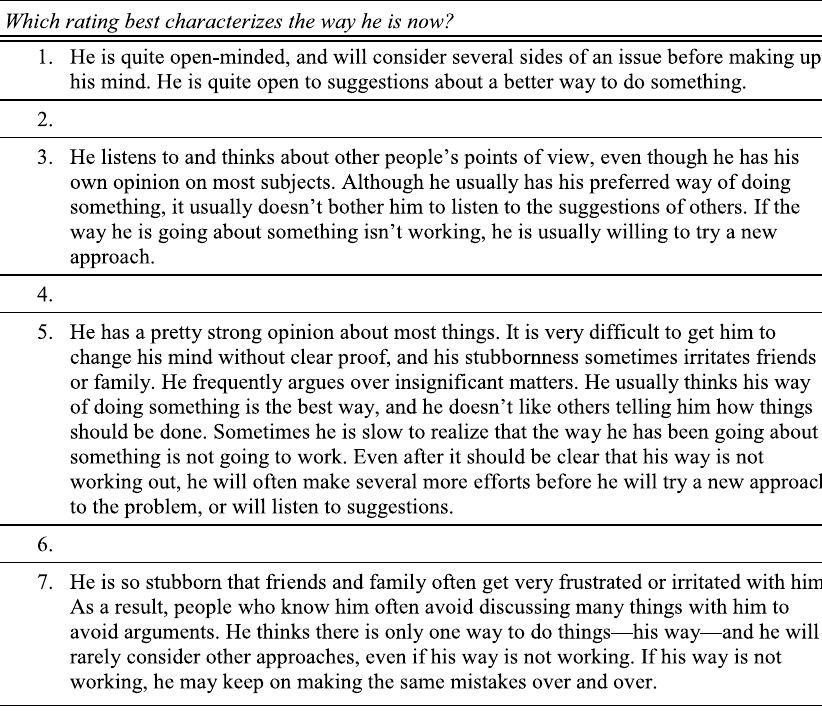
Fig. 1. Example of a rating sheet for one item of the ISPC (total number of items: 29). For each item, a rating of 1 indicates excellent, 3 average, 4–5 moderate disturbance, and 6–7 severe disability. Ratings 1, 3, 5, and 7 correspond to brief definitions of the worsening of the different behavioral characteristics, while ratings 2, 4, and 6 reflect intermediate